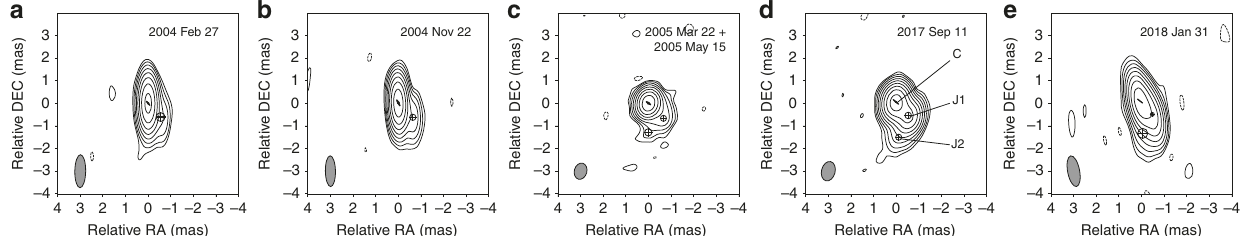
Fig. 1 Radio morphology of J0906 + 6930 derived from VLBA observations at six epochs. The data of 22 March 2005 and 15 May 2005 are combined to create a single image ( c ). Symbols (elliptical and circular Gaussian) represent the model fi tting of emission components. Detailed imaging parameters are listed in Supplementary Table 2. The noise rms is 0.18, 0.19 and 0.16 mJy beam − 1 for the 2004 – 2005 epoch images ( a , b and c , respectively) and is much smaller at 0.034 and 0.057 mJy beam − 1 for the 2017 and 2018 epoch images (panels d and e , respectively). The core C is the brightest and most compact. Two jet components, marked as J1 and J2, are detected within 1.5 mas away from the core. The contours increase by a factor of 2. The grey ellipse at the bottom left corner of each panel represents the full-width at half-maximum (FWHM) of the restoring